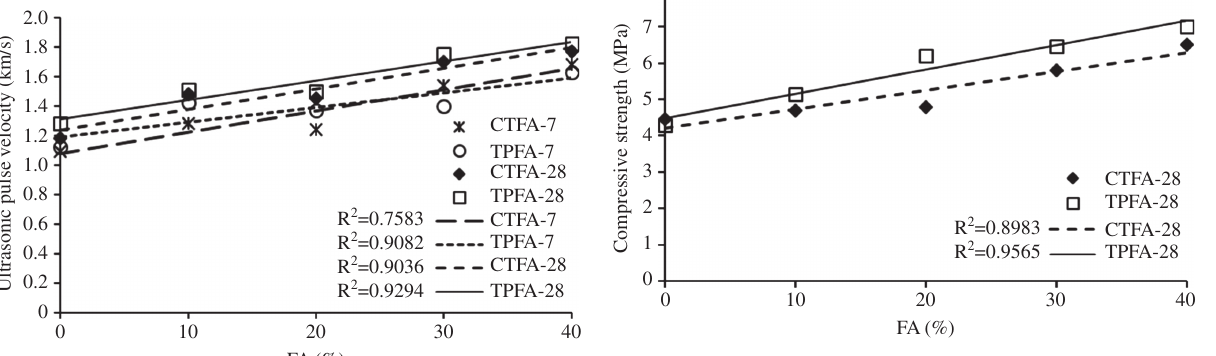
Figure 3 Ultrasonic pulse velocity of specimens.